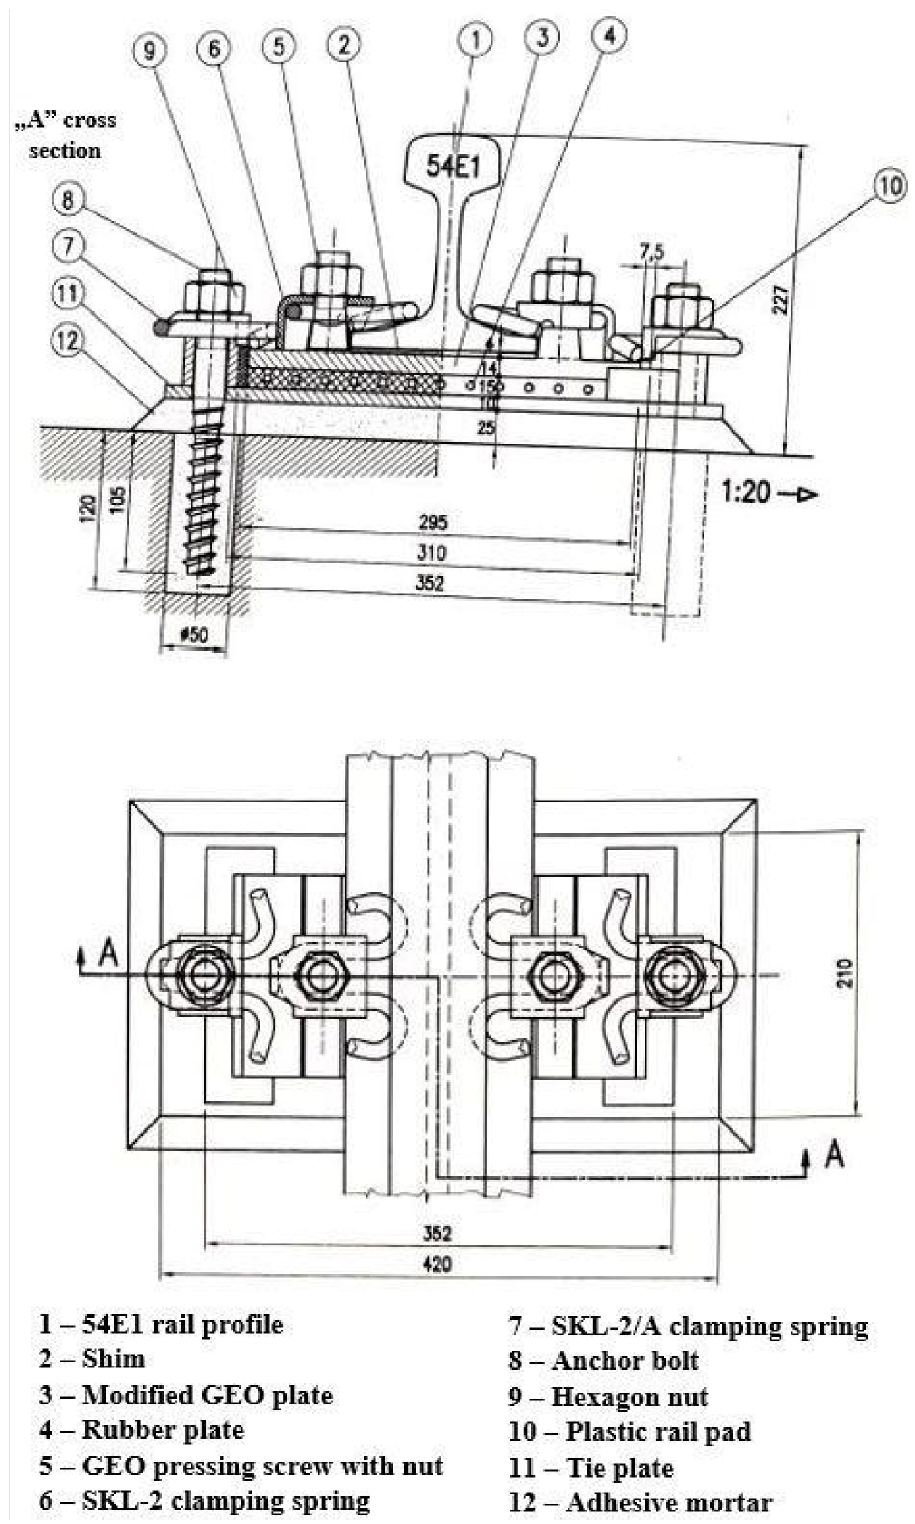
Figure 6. METRO III. type rail fastening (on the basis of